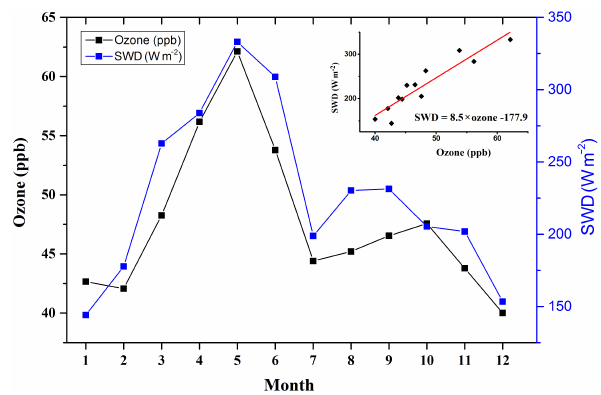
Figure 6. Comparison between monthly average surface ozone (black) and monthly average SWD (downward shortwave radiation; blue) at Nam Co Station in